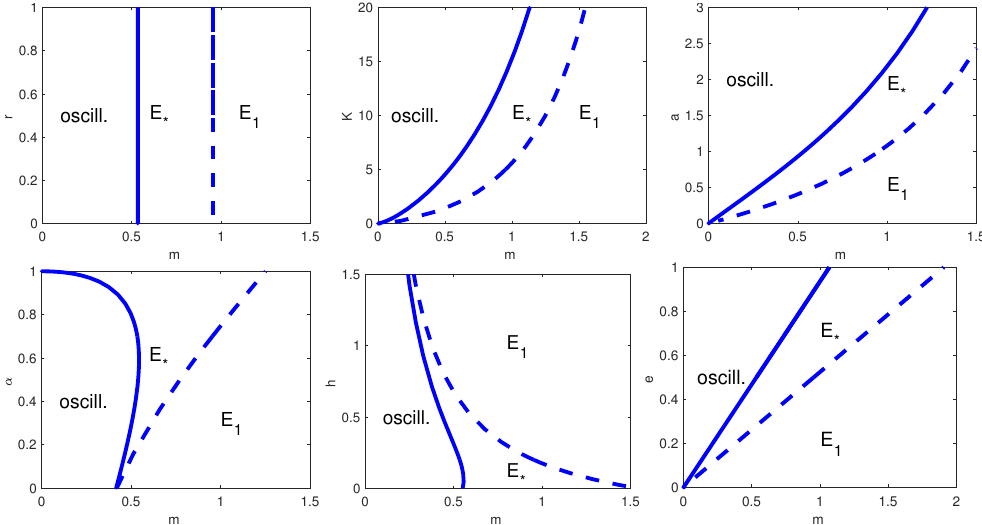
Figure 6. Two-parameter bifurcation diagram with respect to m and, from top left to bottom right, r , K , a , α , h and e . Thick line: HB curve; dashed line: transcritical bifurcation curve. E ∗ is the coexistence equilibrium and E 1 the prey-only equilibrium. The remaining parameter values are as in Table